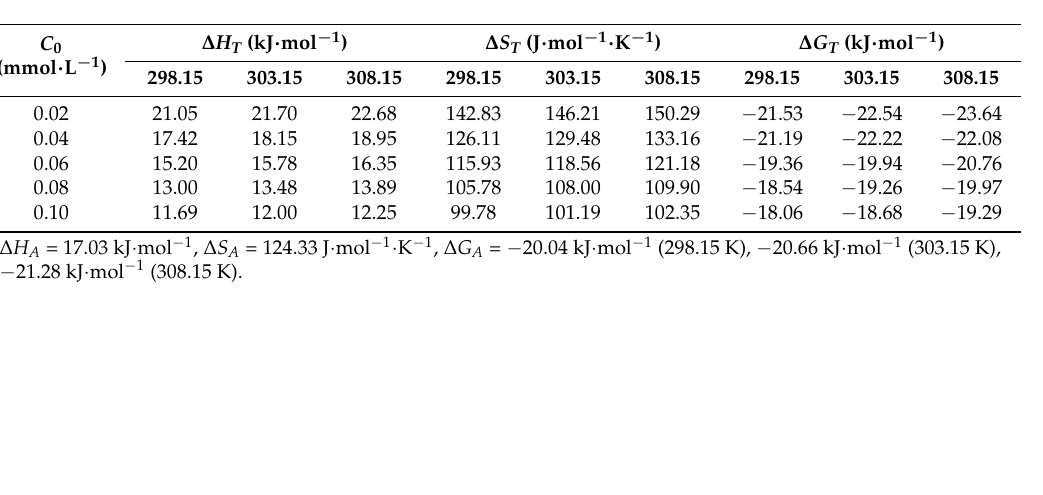
Table 3. Thermodynamic parameters of SDT-A for Cd(II) adsorption on